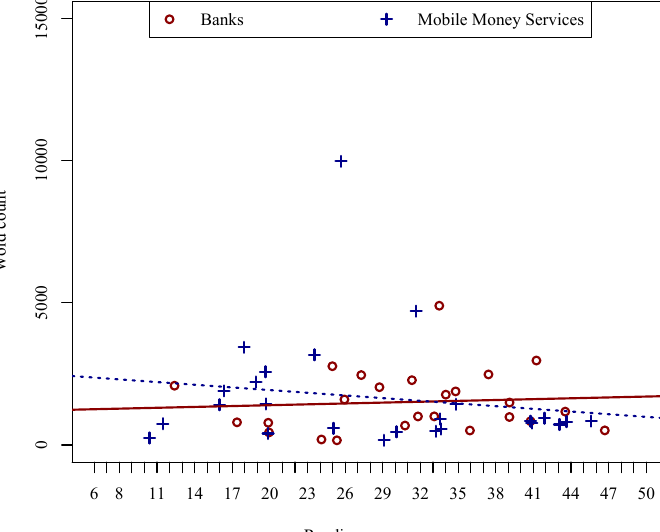
Figure 6. Reading ease score vs. word count of Middle Eastern bank and mobile money policies.